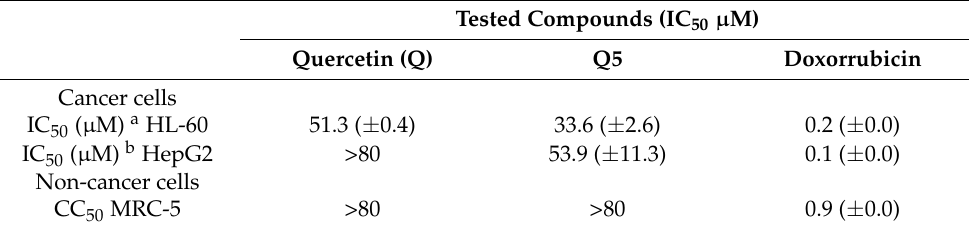
Table 1. Cytotoxicity of the compounds Quercetin (Q) and Quercetin penta-acetate (Q5) against the healthy cell line MRC-5 (human lung fibroblasts) and different cancer cell lines: HepG2 (human hepatocellular carcinoma), HL-60 (human promyelocytic leukemia) and C6 (rat glioma) .